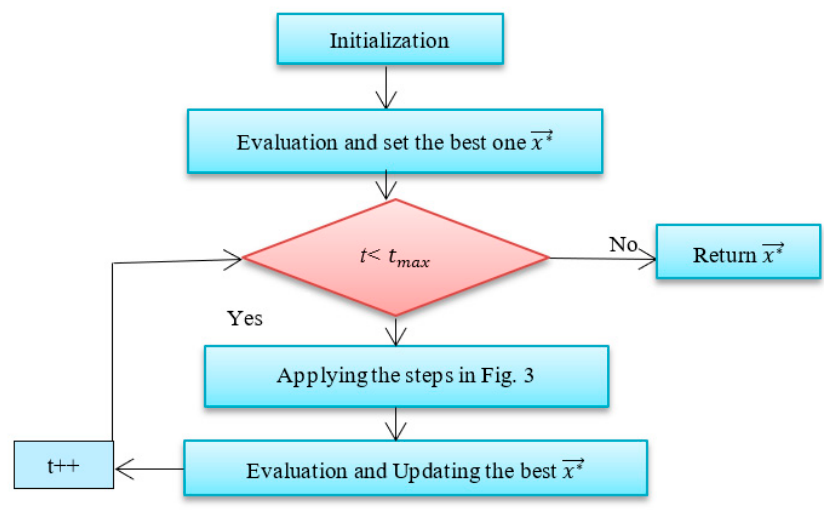
Figure 3. Flowchart of the time control mechanism.